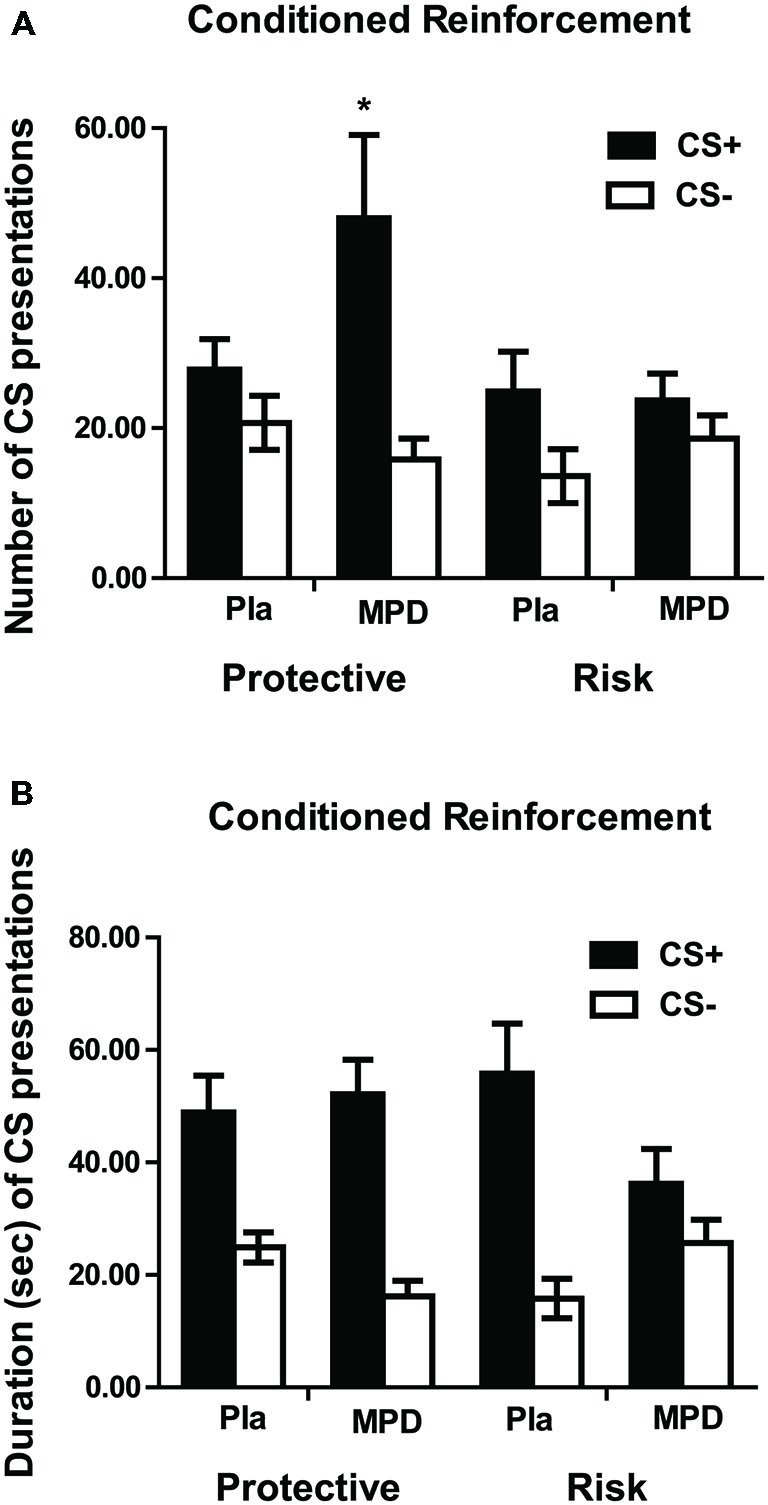
Number of CS presentations (A) and duration of CS presentations (B) for the CS+ and CS− in the 2 min of CRf measurement. Data (mean ± SEM) are given for risk and protective genotype and for methylphenidate (MPD) and placebo (Pla) treatments. A significant drug by genotype by stimulus interaction was found for the number of CS presentations due to an increase in the number of CS+ presentations under methylphenidate in the protective but not in the risk genotype. A significant drug by genotype by stimulus interaction was found also for the duration of CS presentations, indicating a decrease in duration of CS+ presentation under methylphenidate, in comparison to placebo, in the risk but not in the protective genotype.